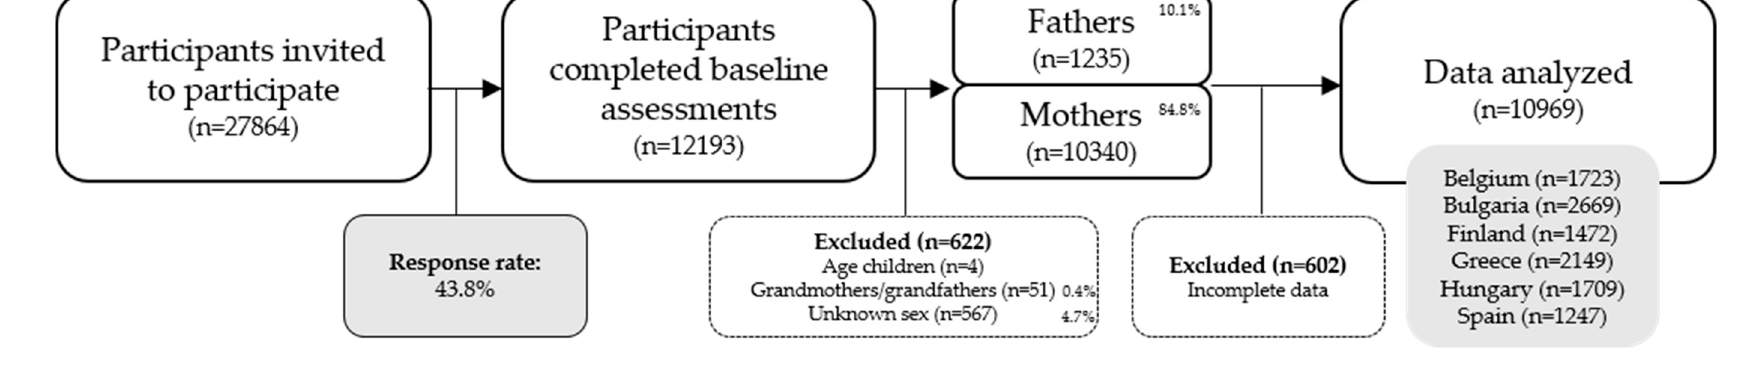
Figure 1. Flow diagram of participants throughout the study.